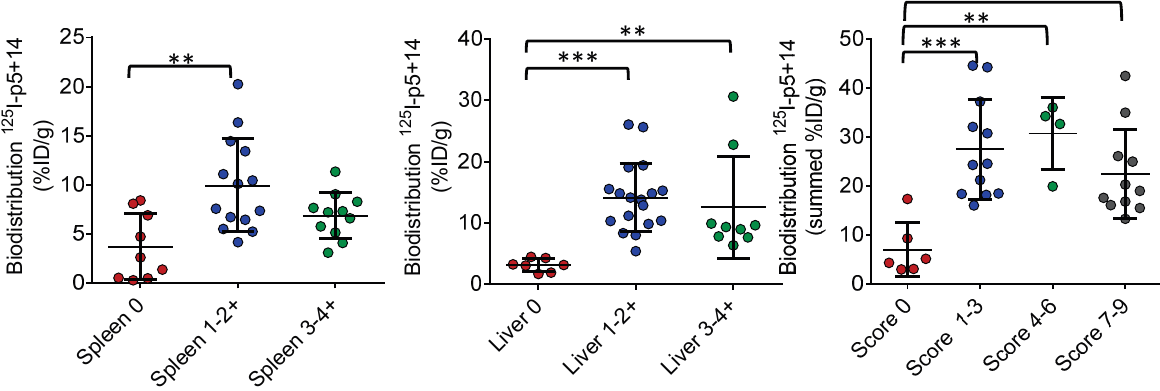
Figure 5. Accumulation of 125 I-p5+14 in AA amyloid laden spleen, liver, and whole